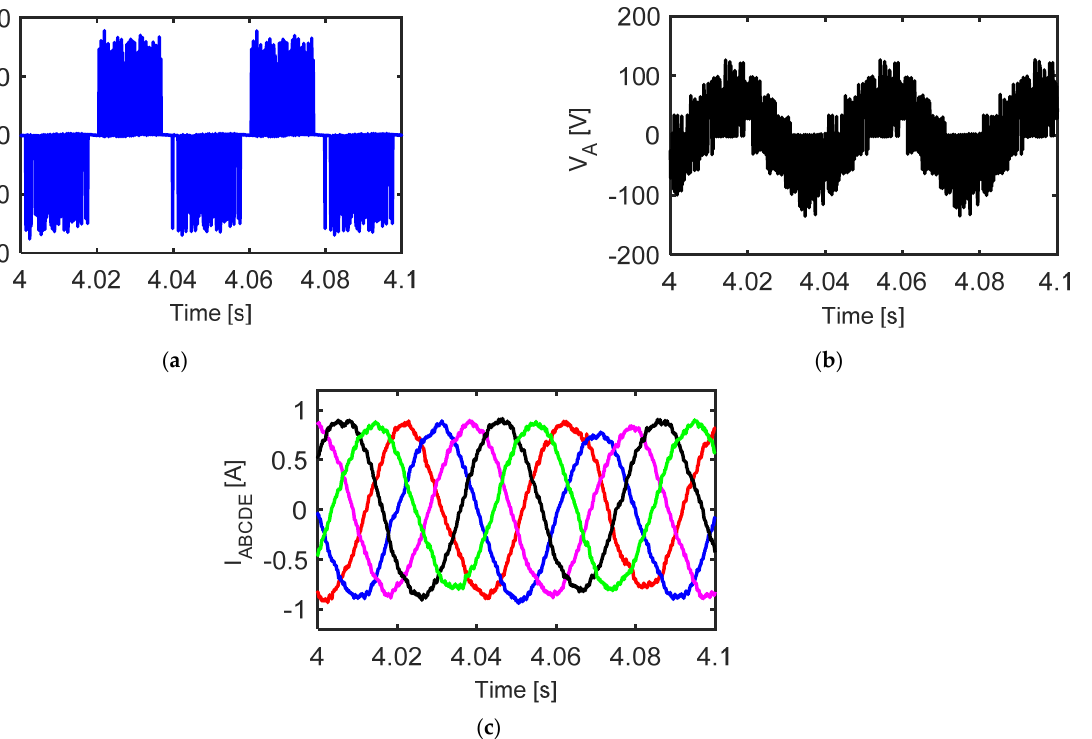
Figure 19. Experimental results at 25 Hz output frequency ( a ) output line voltage, ( b ) output phase voltage and ( c ) output phase currents.